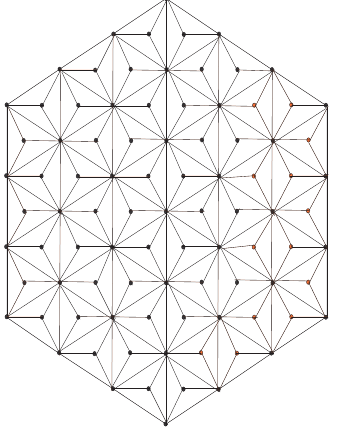
Figure 1: A 4-dimensional hex-derive network HDN 1(4)